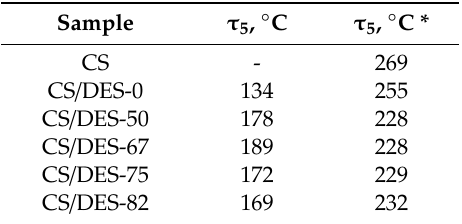
Table 2. TGA results of decomposition process of